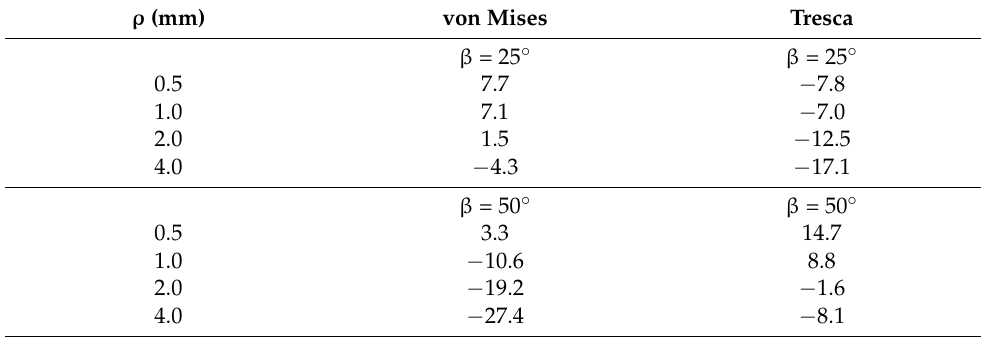
Figure 10. Plastic zones obtained from FE analyses and the proposed methodology based on the Tresca yield criterion, with notch tip radii of ( a ) 0.5 mm, ( b ) 1 mm, ( c ) 2 mm, and ( d ) 4 mm. Notch rotation angle = 50°. Applied loads were 40, 43, 50, and 55 kN, respectively. Table 1. Discrepancies ( Δ , %) between the results obtained from the numerical and analytical solutions for the EPZS based on the von Mises and Tresca yield criteria.